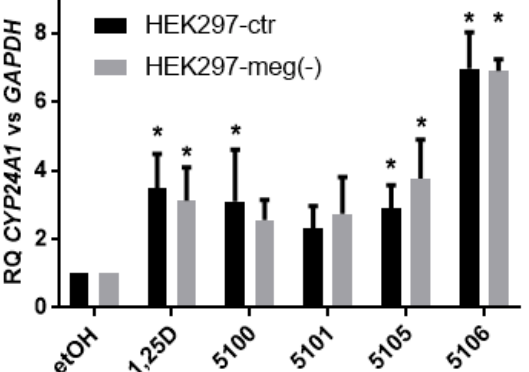
Figure 6. Expression of CYP24A1 in response to 1,25D3 and to analogs in HEK297-ctr and HEK297-meg( − ) cells. The cells were exposed to 10 nM 1,25D3 or 10 nM analogs, and after 48 h the expression of CYP24A1 mRNA was measured by real-time PCR. The bar charts show the mean values (±SD) of the fold changes in mRNA levels relative to GAPDH mRNA levels. Values that differ significantly from those obtained for respective control cells are marked with *.